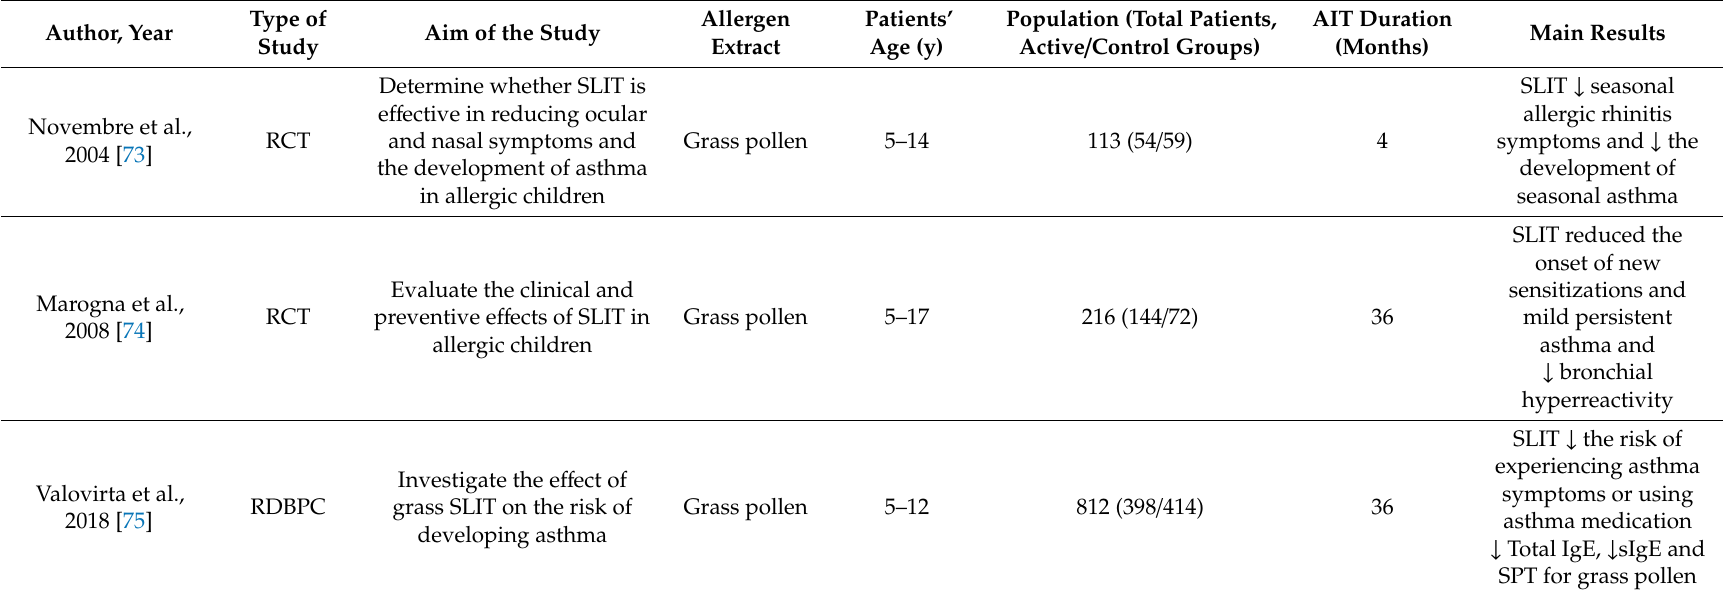
Table 2. Studies on the long-term e ff ect and preventive role of SLIT in allergic